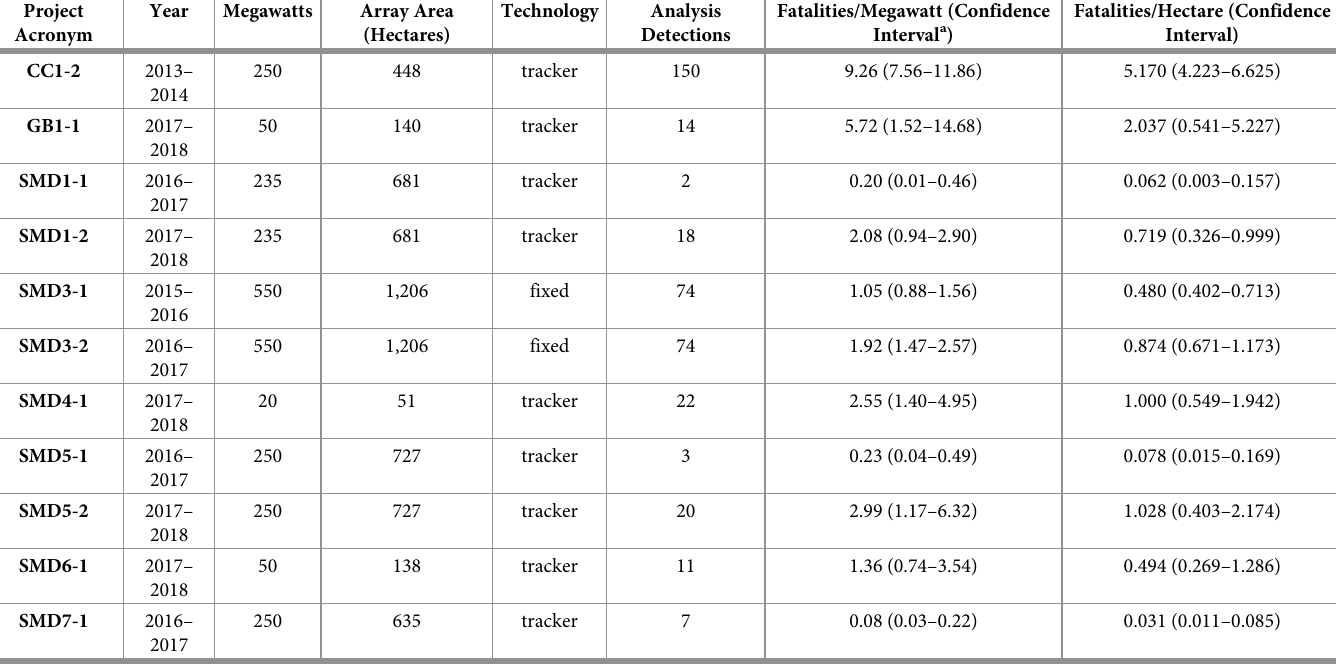
Table 4. Annual all bird fatality estimates, adjusted for detection probability and search effort, per megawatt nameplate capacity and per hectare (with confidence intervals), for 11 fatality monitoring studies at photovoltaic solar facilities in California and Nevada from January 1, 2013, to September 1, 2018. Project